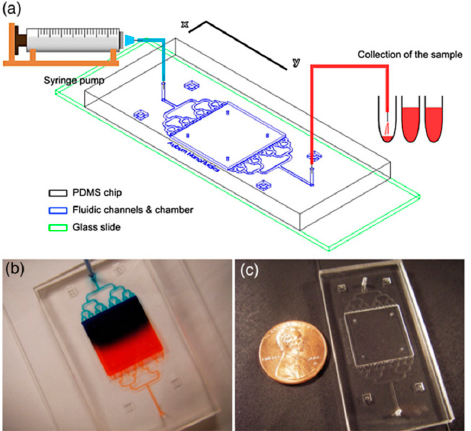
Figure 3. The microfluidic system design. Republished with permission from Ali et al. [45].